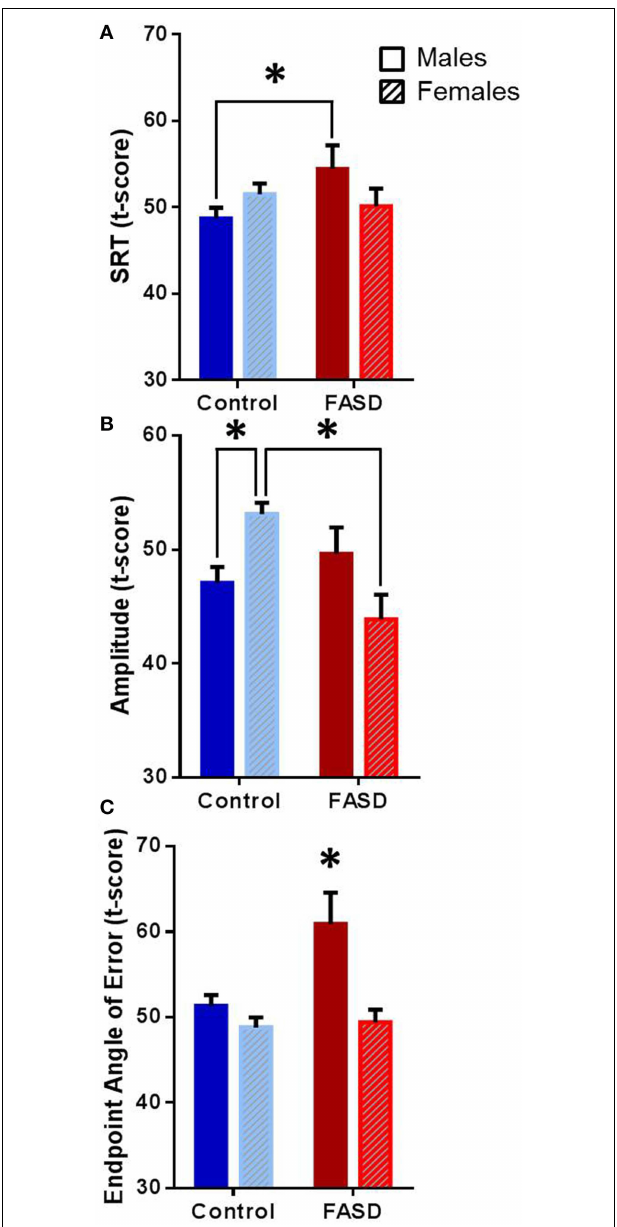
FIGURE 2 | Overall data. Data are mean ± SEM for participants in the FASD group ( n = 71 ) shown in red and the control group ( n = 113 ) shown in blue. (A) Males with FASD had significantly slower saccadic reaction time (SRT) compared to control males. (B) Control females had significantly greater amplitude compared to control males and females with FASD. (C) Males with FASD had significantly greater endpoint angle of error compared to all other groups. ∗ p < 0 . 05 compared to group indicated or all other